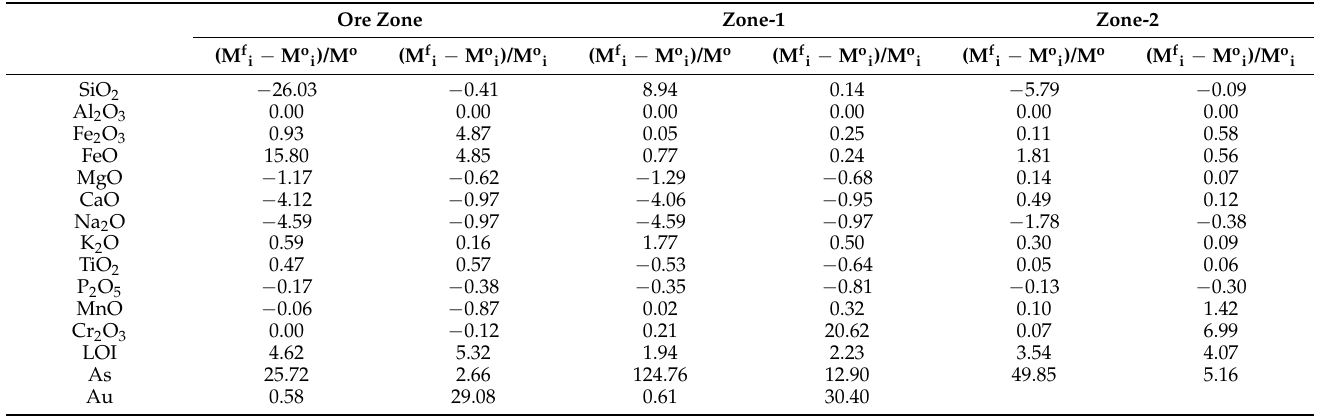
Table 5. Elements/oxides mass changes in relation to original whole rock mass ((M f i − M o i )/M o ) and in relation to original elements/oxides mass in original rock ((M f i − M o i )/M o i ) (data from GEOISO-A Windows™